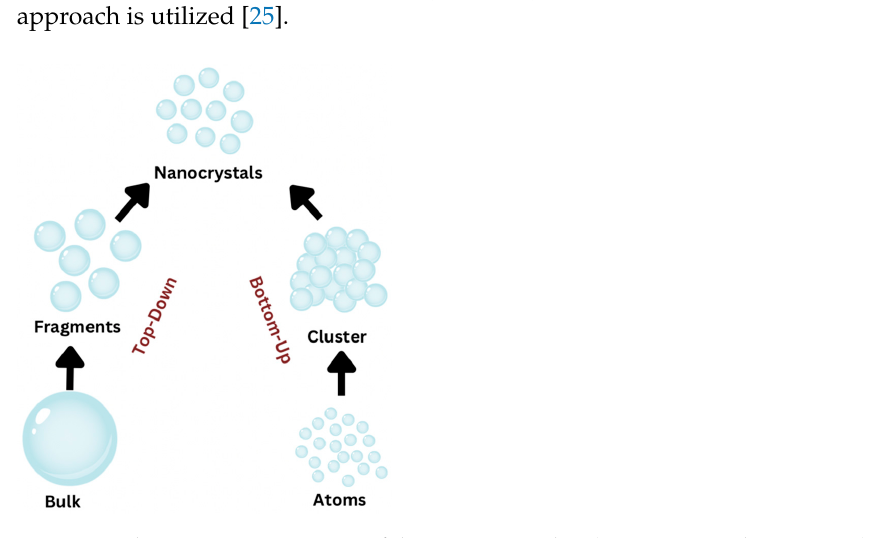
Figure 1. Schematic representation of the two approaches (Top-Down and